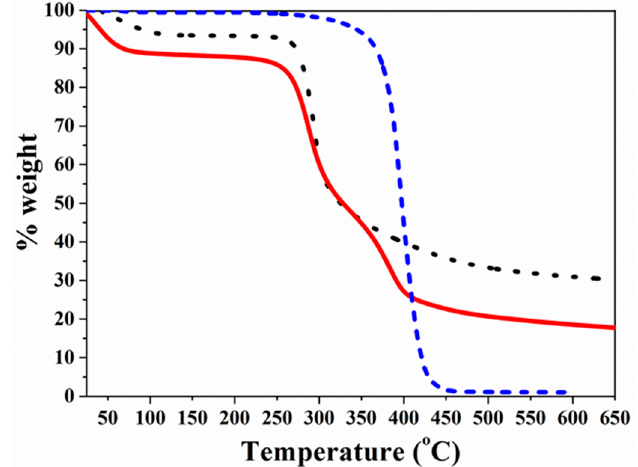
Figure 3. Thermogravimetric analysis curves of discoid samples of CS ( ⋯ ), PCL-COOH ( – – – ), and CS- g -PCL ( —